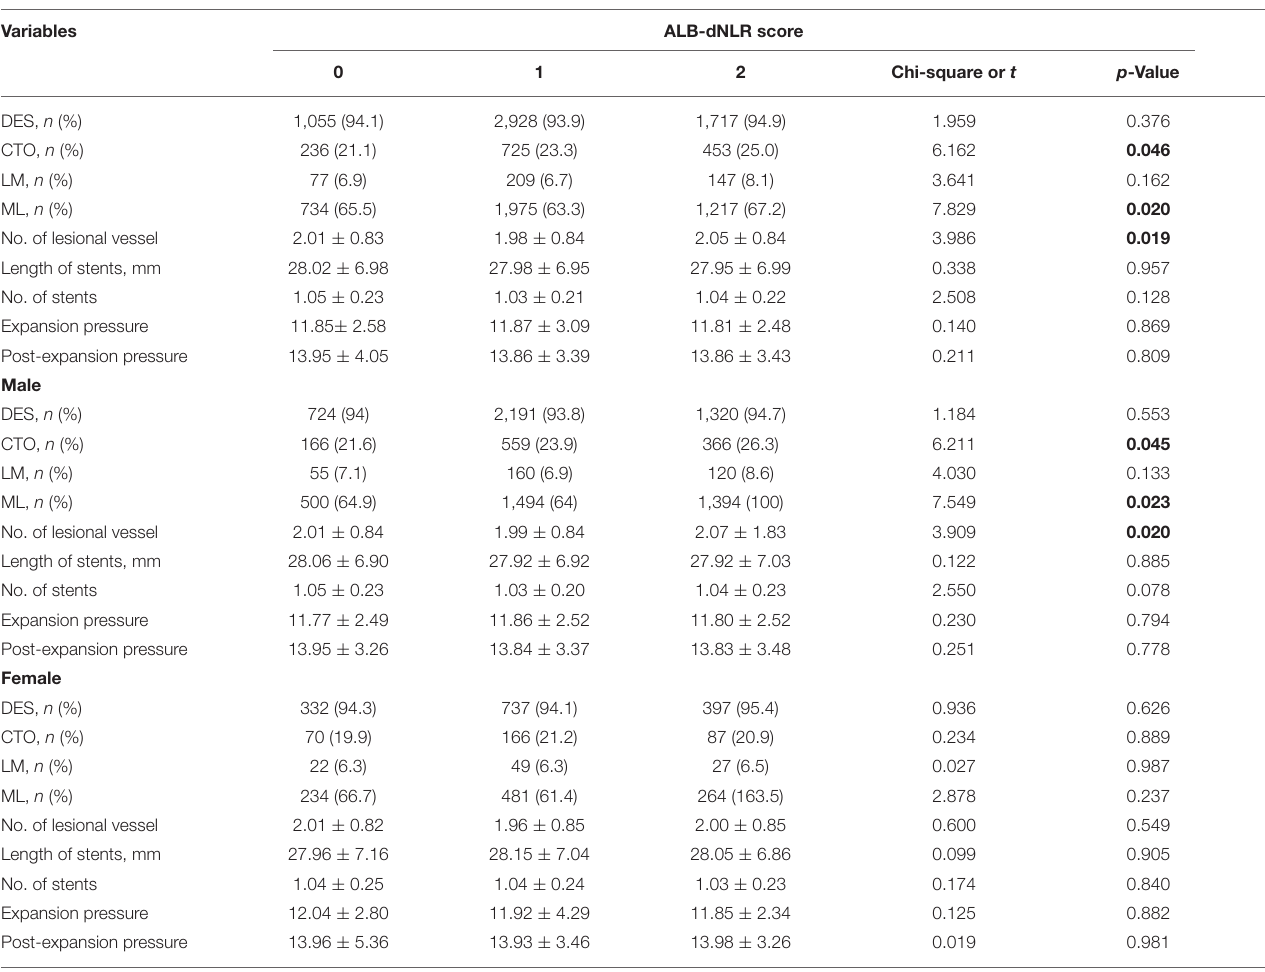
TABLE 2 | Baseline treatments and procedure characteristics. Variables